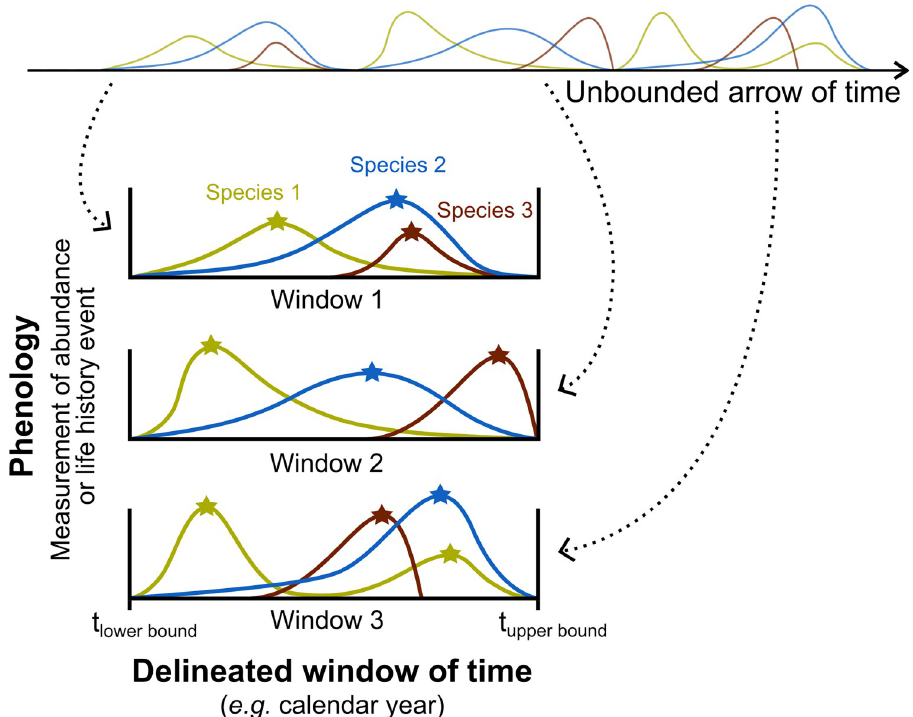
Fig 2. Phenology is a study of repeated patterns of events in the dimension of time. Delimiting the continuous arrow of time into natural units such as years or climatic growing seasons allows observers to compare patterns between cycle periods and quantify change such as phenological shifts. Shapes of seasonal patterns (colored curves), peak dates (location of stars), or number of peaks (e.g., species 1 has 2 peaks in window 3) can be taken to measure change, e.g., in units of days. Systematic quantification and comparisons then provide the necessary groundwork for studying ecological and evolutionary causality.